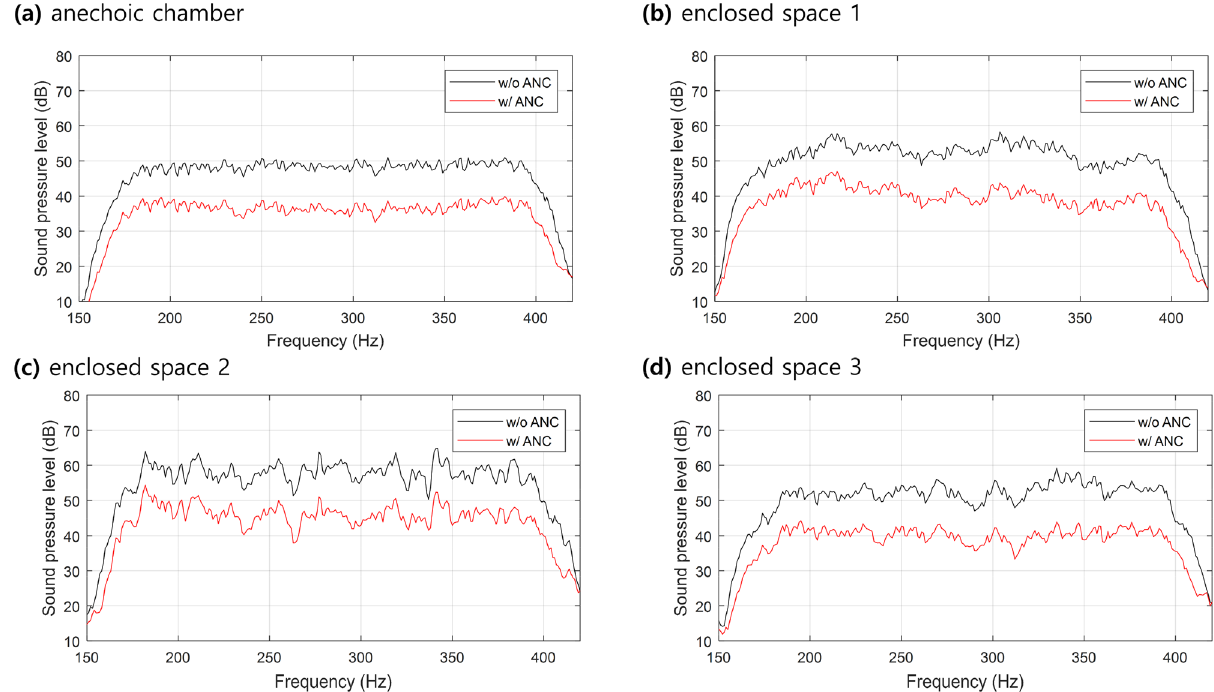
Figure 8. Frequency domain global ANC experiment results of an average of nine monitoring microphones. ( a ) Anechoic chamber; ( b ) Enclosed space 1 (small size, small reverberation time). ( c ) Enclosed space 2 (small size, large reverberation time). ( d ) Enclosed space 3 (large size). Black lines indicate noise before ANC, and red lines indicate noise after ANC.